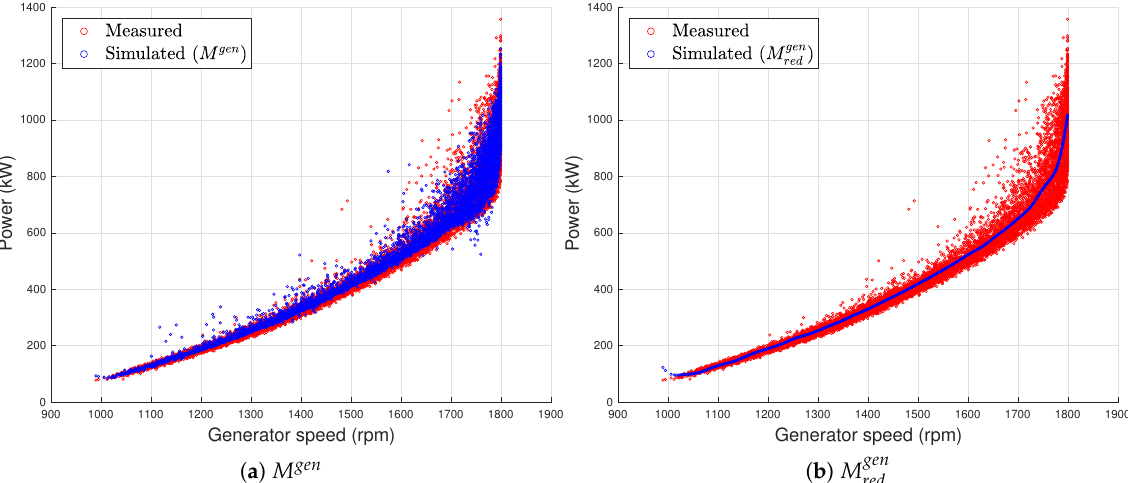
Figure 9. Measured and simulated generator speed-power curves: D2 data set, T1 wind turbine. M gen model on the left, M gen on the red